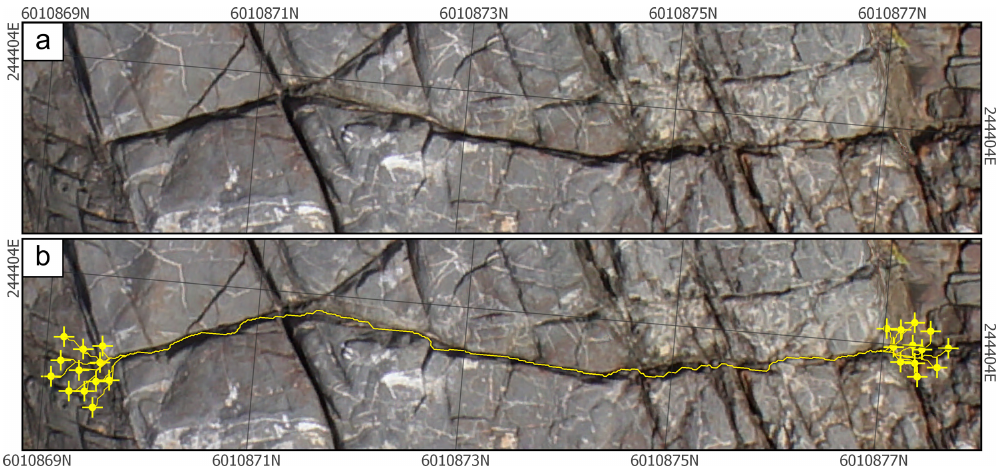
Figure 7. Fracture (a) from the Bingie Bingie Point dataset showing that the majority of the resulting trace (b) consistently follows the same path despite variation in the location of the control